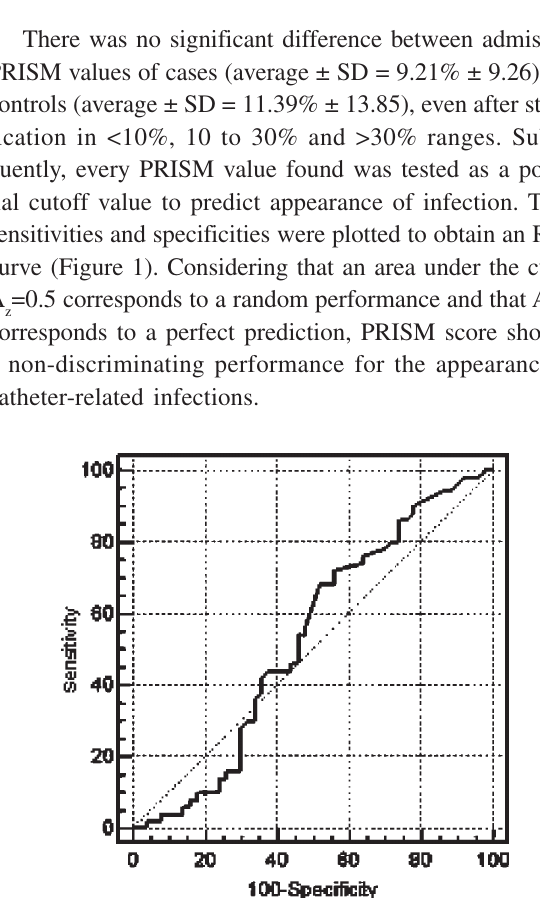
Figure 1 - Admission PRISM score’s discriminatory power for catheter- related infection (CRI) evaluated by Receiver Operating Characteristic (ROC) = 0.528 (95% confidence interval = 0.426 to curve. Area under the curve, A z